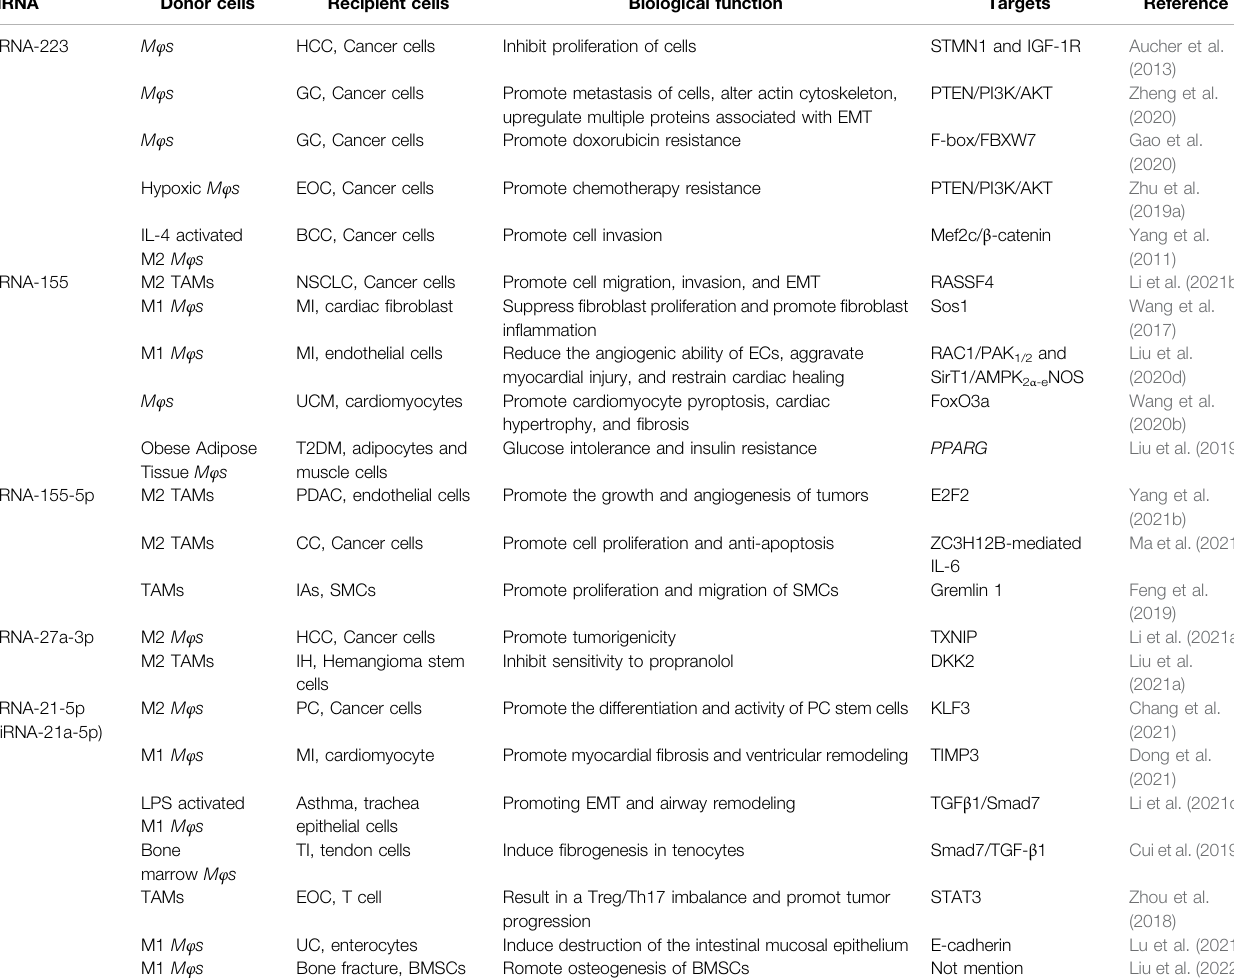
TABLE 1 | The same miRNA/lncRNA exerts different biological functions. MiRNA Donor